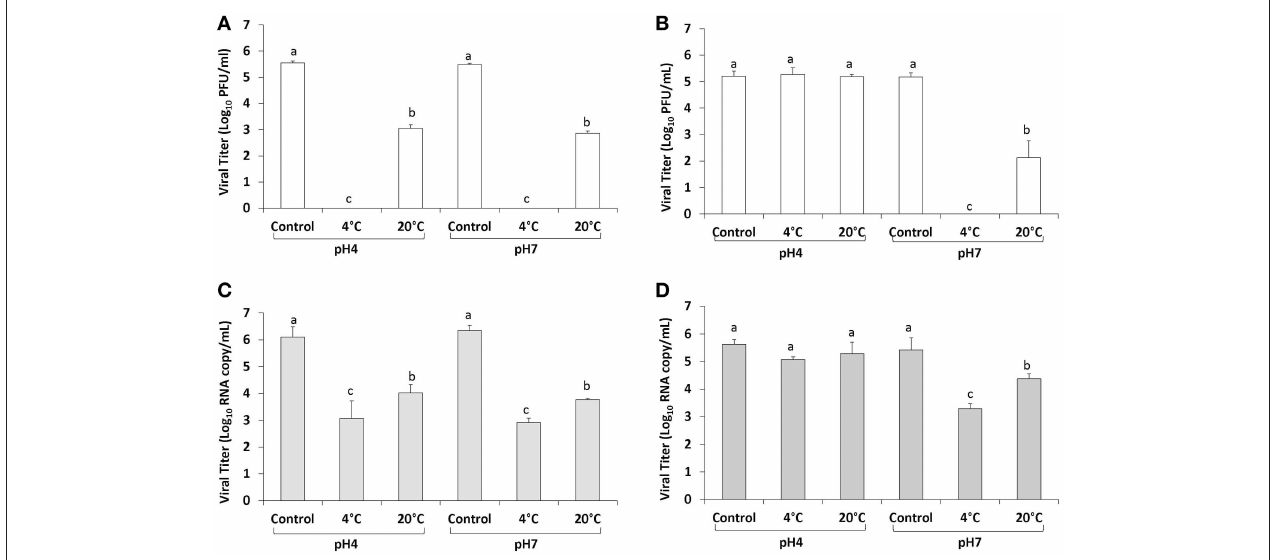
FIGURE 3 | TV inactivation by HPP in PBS (A,B) and strawberry puree (C,D) . Each bar represents average of three replicates ± 1 standard deviation. Groupings (a, b, c, d) are based on one-way ANOVA analysis using Tukey’s comparisons, with a 95% C.I. Values with different lowercase letters (a, b, c, d) are significantly different ( p < 0.05) and values sharing the same lowercase letters (a, b, c, d) are not significantly different ( p >